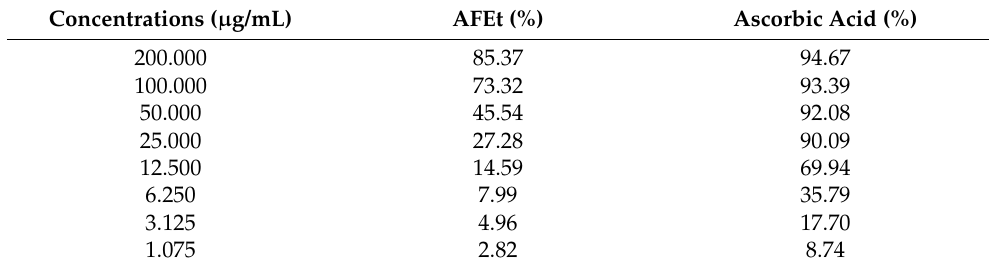
Table 2. DPPH radical scavenging activity results for AFEt and ascorbic acid (%). Concentrations ( µ g/mL) AFEt (%)